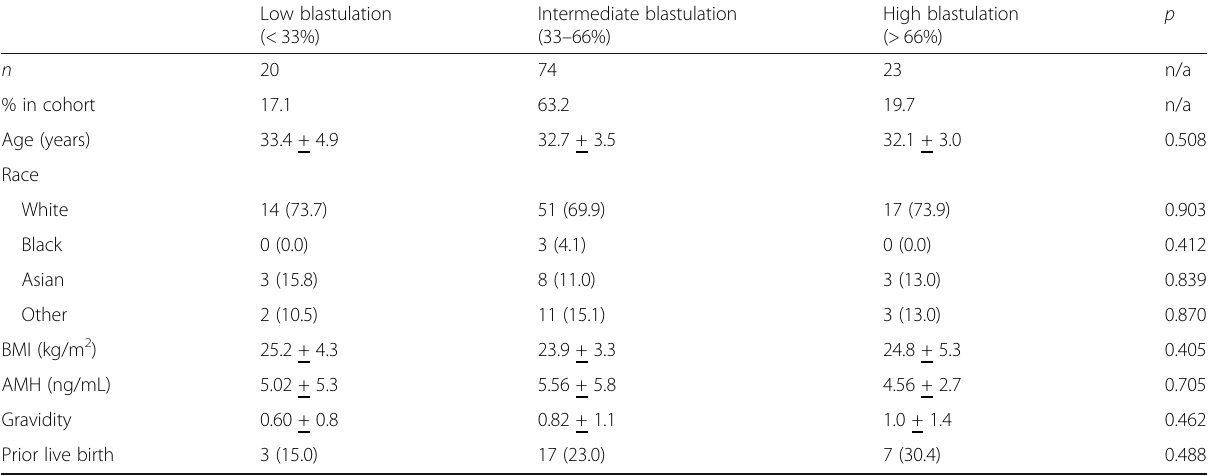
Table 2 Patient characteristics by variable blastulation